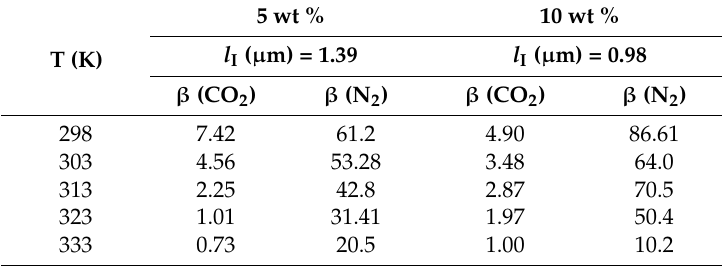
Table 4. Parameters estimated by the reduced mobility modified Maxwell model for the CHA/PTMSP